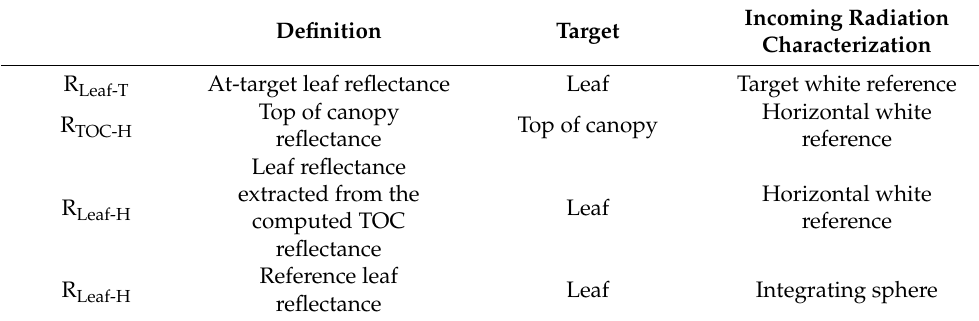
Table 1. Reflectance measurements compared in this